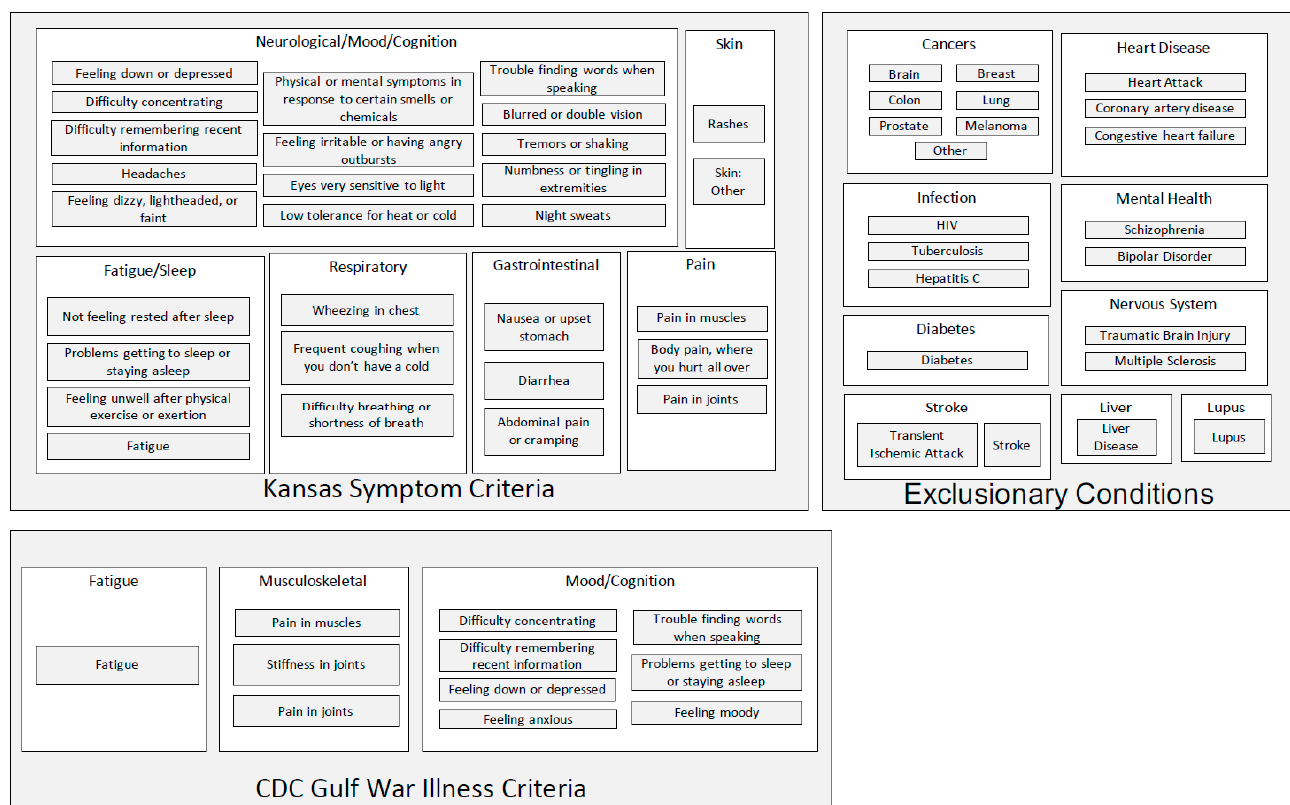
Figure 1. The Kansas [24] and CDC [23] case definitions of Gulf War